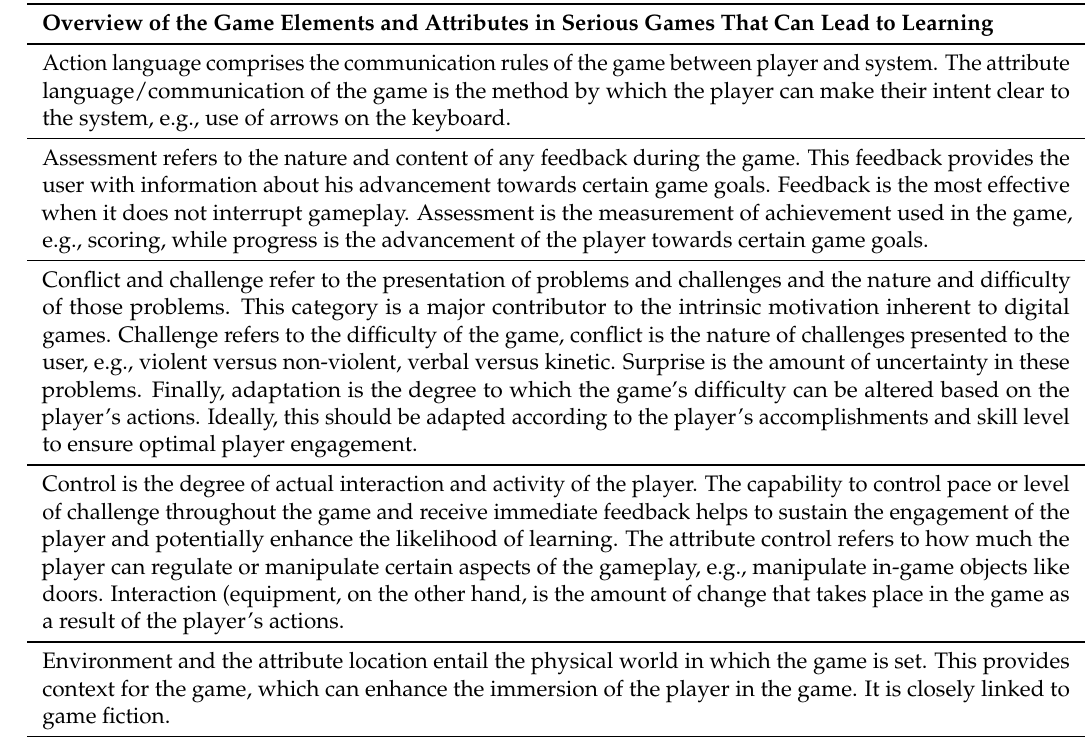
Table 3. Game elements and their respective attributes relevant to learning